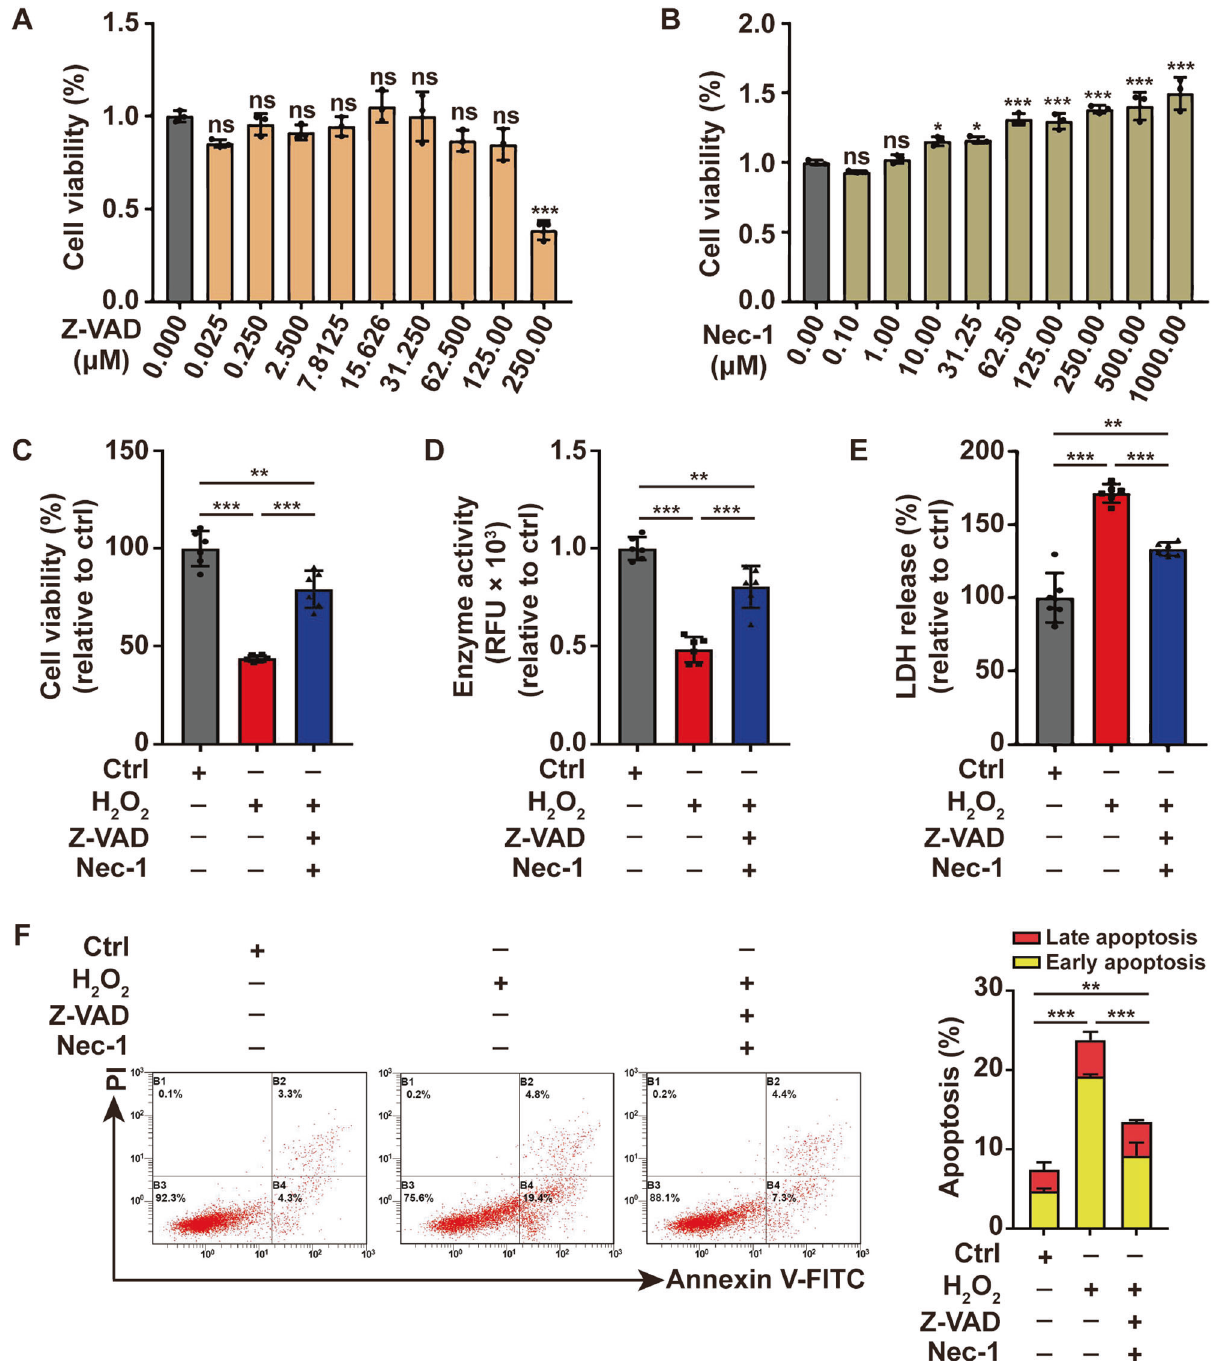
in PIG1 cells was determined by CCK-8 assay. The cell viability of PIG1 cells treated by H 2 O 2 or pretreated with Z-VAD and Nec-1 prior to H 2 O 2 disposition is determined by CCK8 assay ( C ) and Resazurin-conversion assay ( D ). E The activity of released LDH in PIG1 cells treated by H 2 O 2